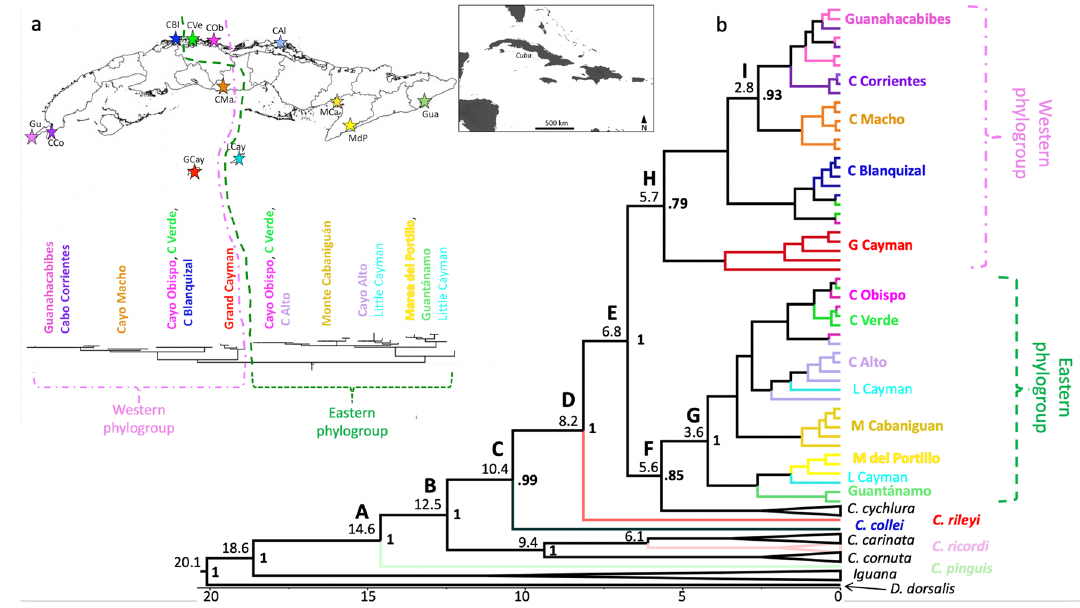
Figure 1. ( a ) Map of sampling localities for Cyclura nubila nubila from Cuba (see Supplementary Table S1) on top and a Bayesian species tree (divergence-time) on the bottom, indicating two divergent phylogroups (Western and Eastern). The geographic location of Cuba is shown in the inserted map. Star symbols and matching colors correspond to the eight sampling sites from this study (Gu: Guanahacabibes, CCo: Cabo Corrientes, CBl: Cayo Blanquizal, CVe: Cayo Verde, COb: Cayo Obispo, CMa: Cayo Macho, CAl: Cayo Alto, MCa: Monte Cabaniguán). Two Cuba sites (MdP: Marea de Portillo and Gua: Guantánamo) and the Cayman islands (GCay: Grand Cayman, LCay: Little Cayman) correspond to sequences obtained from GenBank (see Supplementary Fig. S1). ( b ) Divergence-time estimation (time-scale in millions of years; My) of Cyclura nubila nubila from Cuba and Cyclura species and subspecies across the Caribbean; Iguana iguana , I. delicatissima , and Dipsosaurus dorsalis used as outgroups. Estimated with Beast 1.10.4 78 and based on the ND4/ND5 mitochondrial region. Numbers above branches are mean divergence time in million years, and at nodes depict posterior probability support. The most basal lineages start on the east side of the archipelago, and follow a west to east distribution: Cyclura pinguis , inhabiting Anegada Island, is the most basal haplotype from which two clades are derived, one including C. cornuta (Puerto Rico, Dominican Republic), C. ricordi (Dominican Republic) and C. carinata (Turks and Caicos). The other clade encompasses a basal C. collei (Jamaica) haplotype, followed by C. rileyi (San Salvador) and a C. cychlura (Bahamas) group of haplotypes. Maps were drawn with QGIS v.3.10 (https ://qgis.org/en/site/).